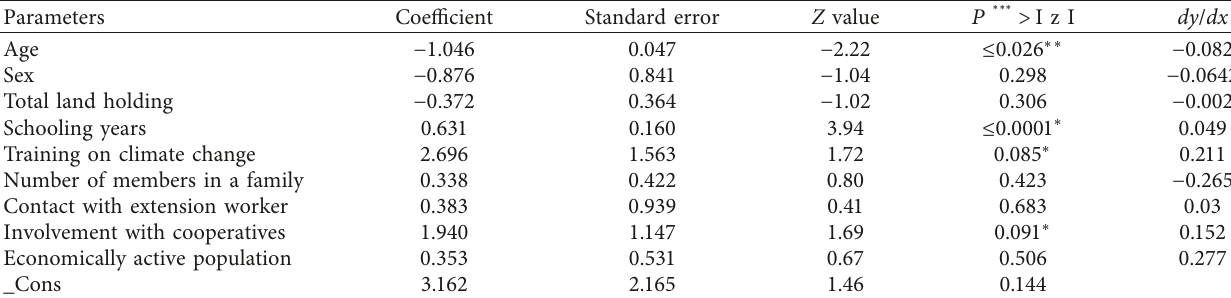
Table 3: Determinants of people’s awareness of climate-smart agriculture